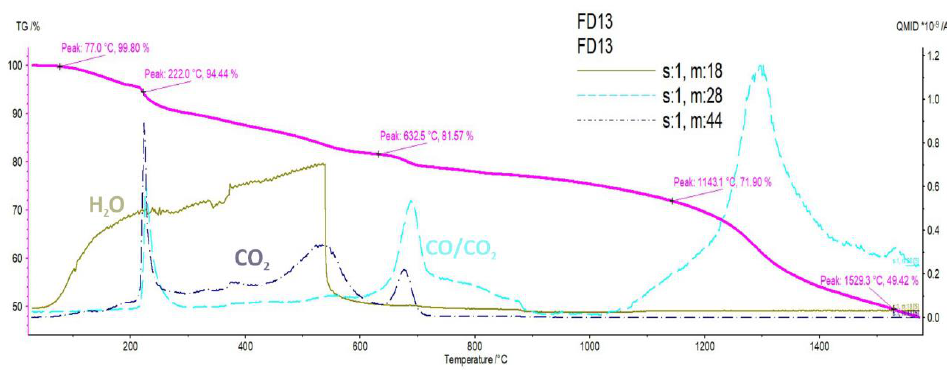
Figure 9. FD13 TGA-MS diagram.